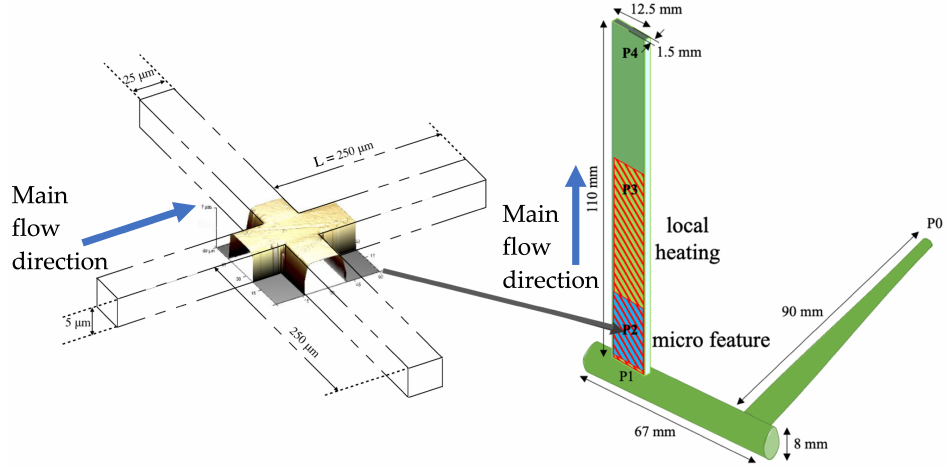
Figure 1. Sketch of the cavity geometry adopted for the injection molding test, with the position in which the insert with micro-crosses is located. The micro-cross AFM acquisition is also